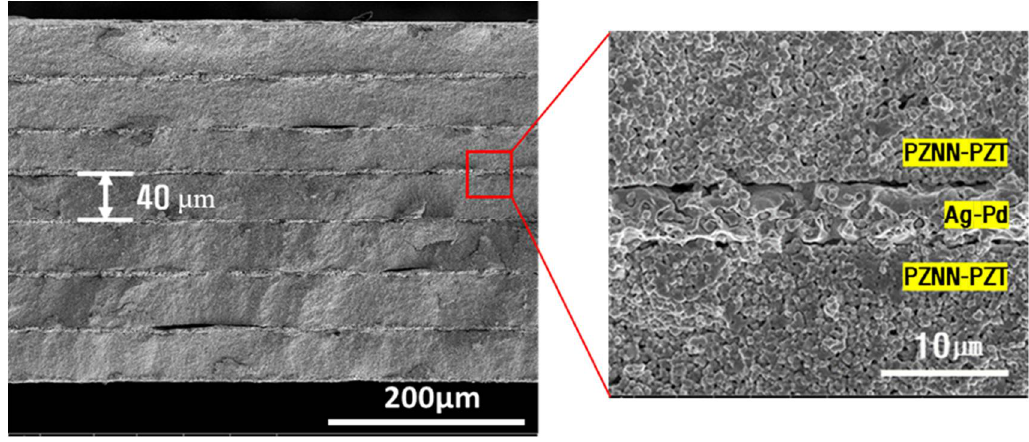
Figure 7. Simulated frequency responses of piezoelectric speakers constructed using acoustic diaphragm structures of different sizes.